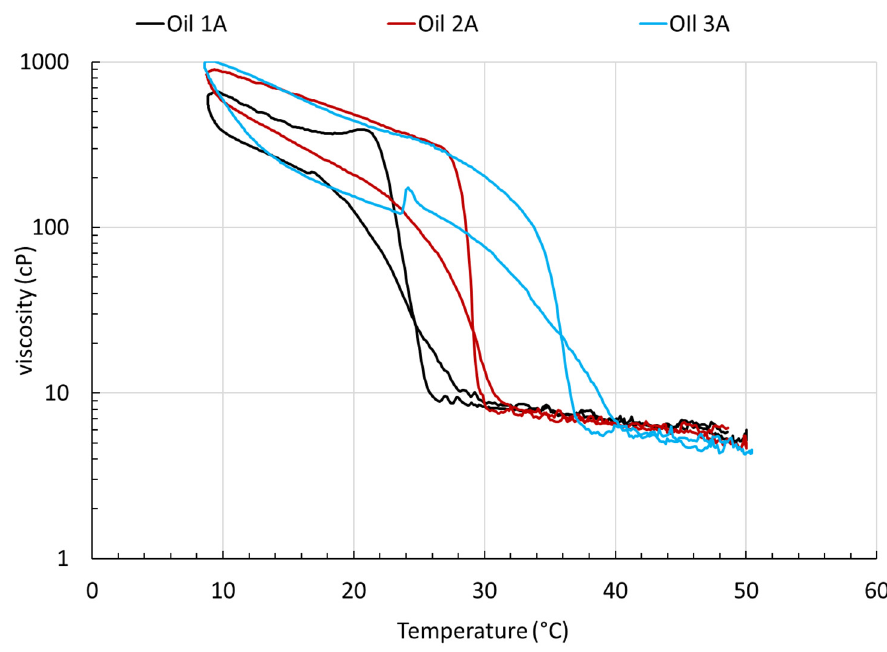
Figure 7. Viscosity as a function of the cooling/heating cycle 50 °C → 8 °C → 50 °C for oils 1A, 2A, and 3A, measured by applying a constant shear of 25 s − 1 and a cooling/heating rate of 1 °C/min.